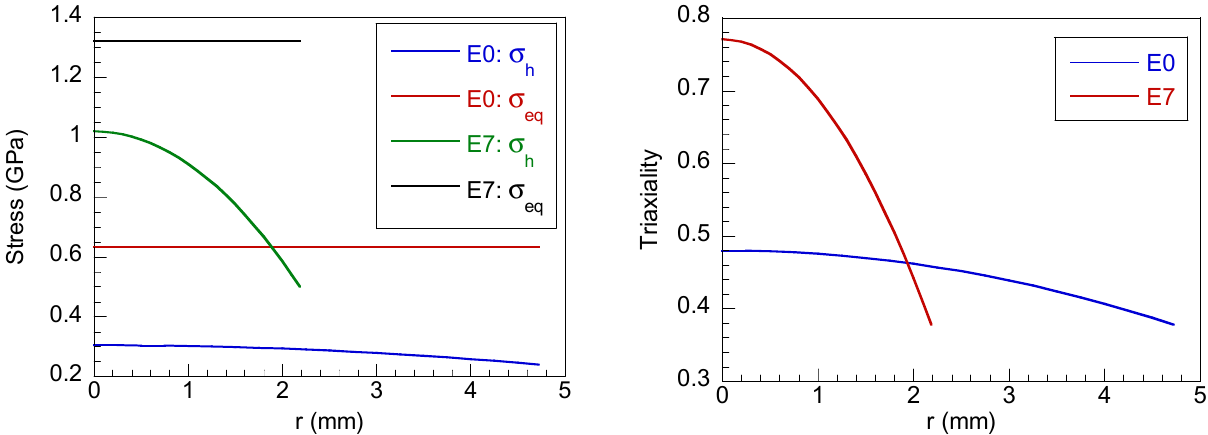
Figure 17. Distribution of hydrostatic stress ( left ), equivalent stress ( left ) and stress triaxiality ( right ) for the hot rolled steel E0 and the prestressing steel E7 along the necking section.